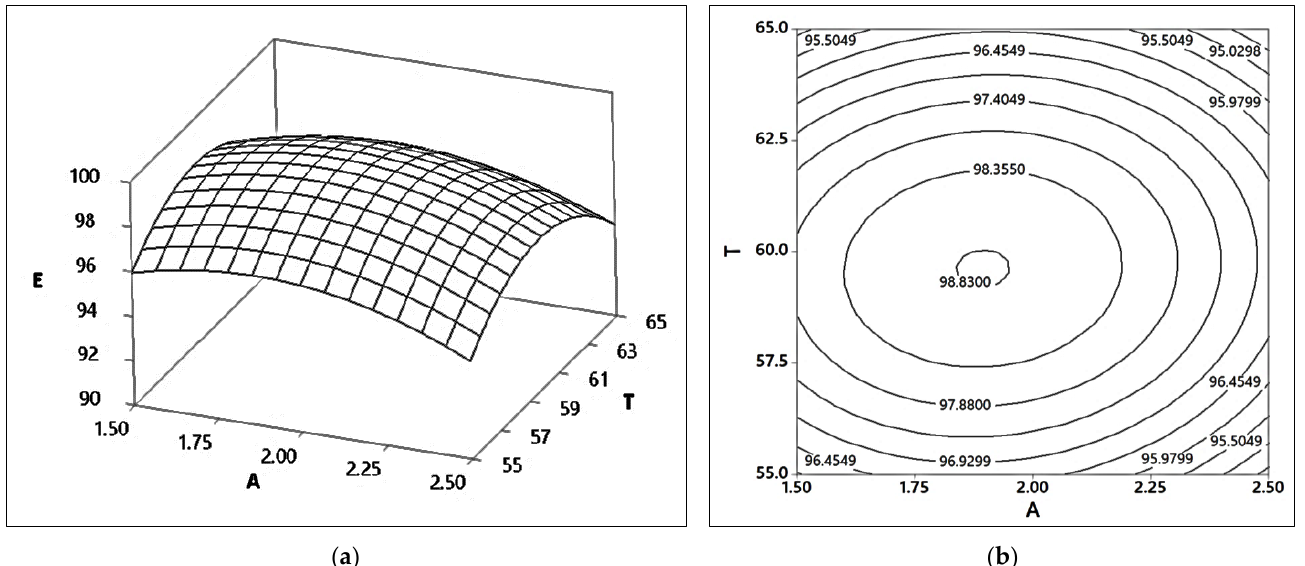
Figure 5. Interaction effect of the methanol to oil molar ratio and reaction temperature on the acidity removal of the WCO esterification process. ( a ) A 3D response surface plot of E (%) vs. A (wt.%) and T (°C). ( b ) A 2D contour plot between A (wt.%) and T (°C).